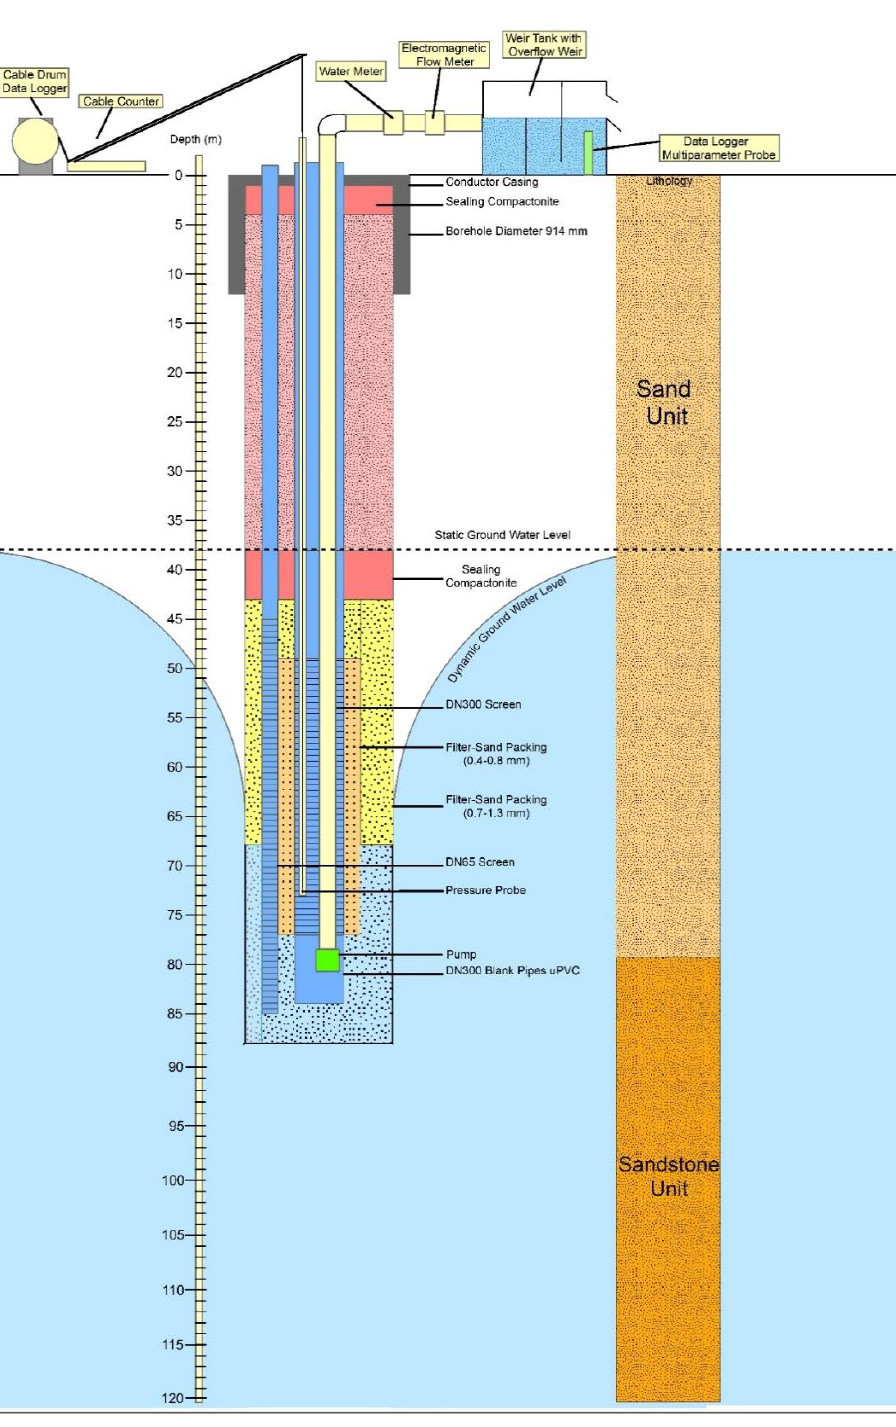
Figure 3. Well Design of the Strategic Water Storage and Recovery Project.